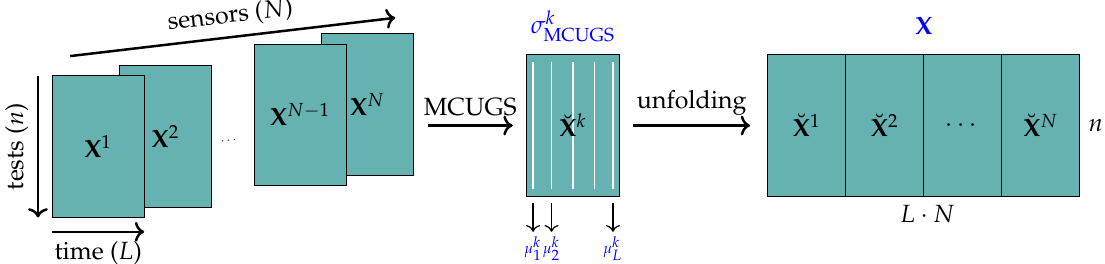
Figure 5. Initial data arrangement, MCUGS, and